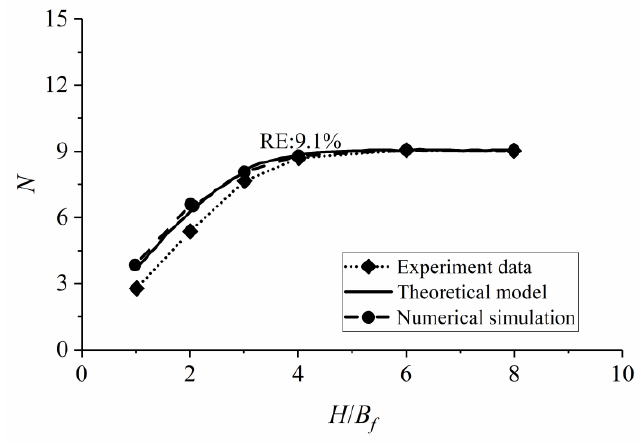
Figure 13. Comparative study on the capacity factor in uniform clay [16,49,50].